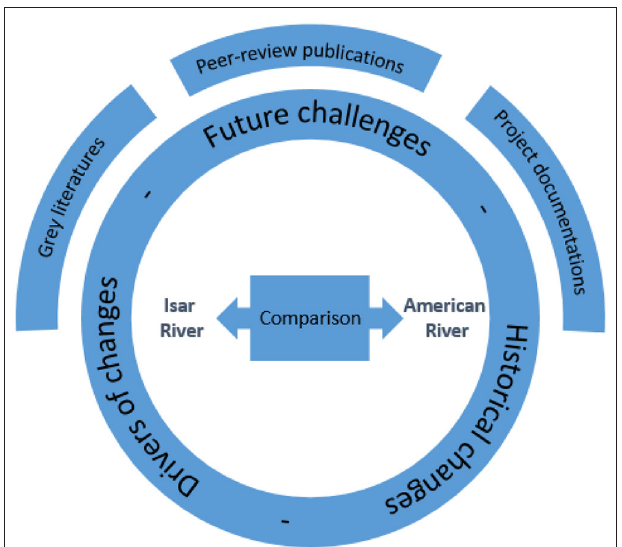
FIGURE 5 | Methodological